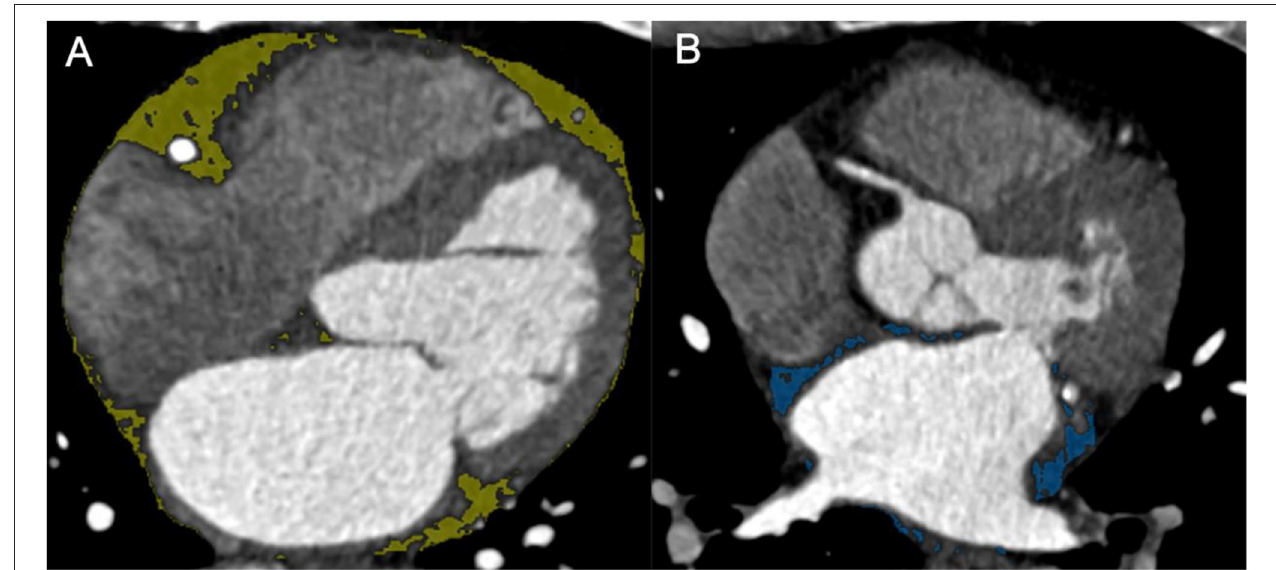
FIGURE 3 | (A) EAT. (B) LA-EAT. EAT, epicardial adipose tissue; LA-EAT, epicardial adipose tissue surrounding the left atrium.